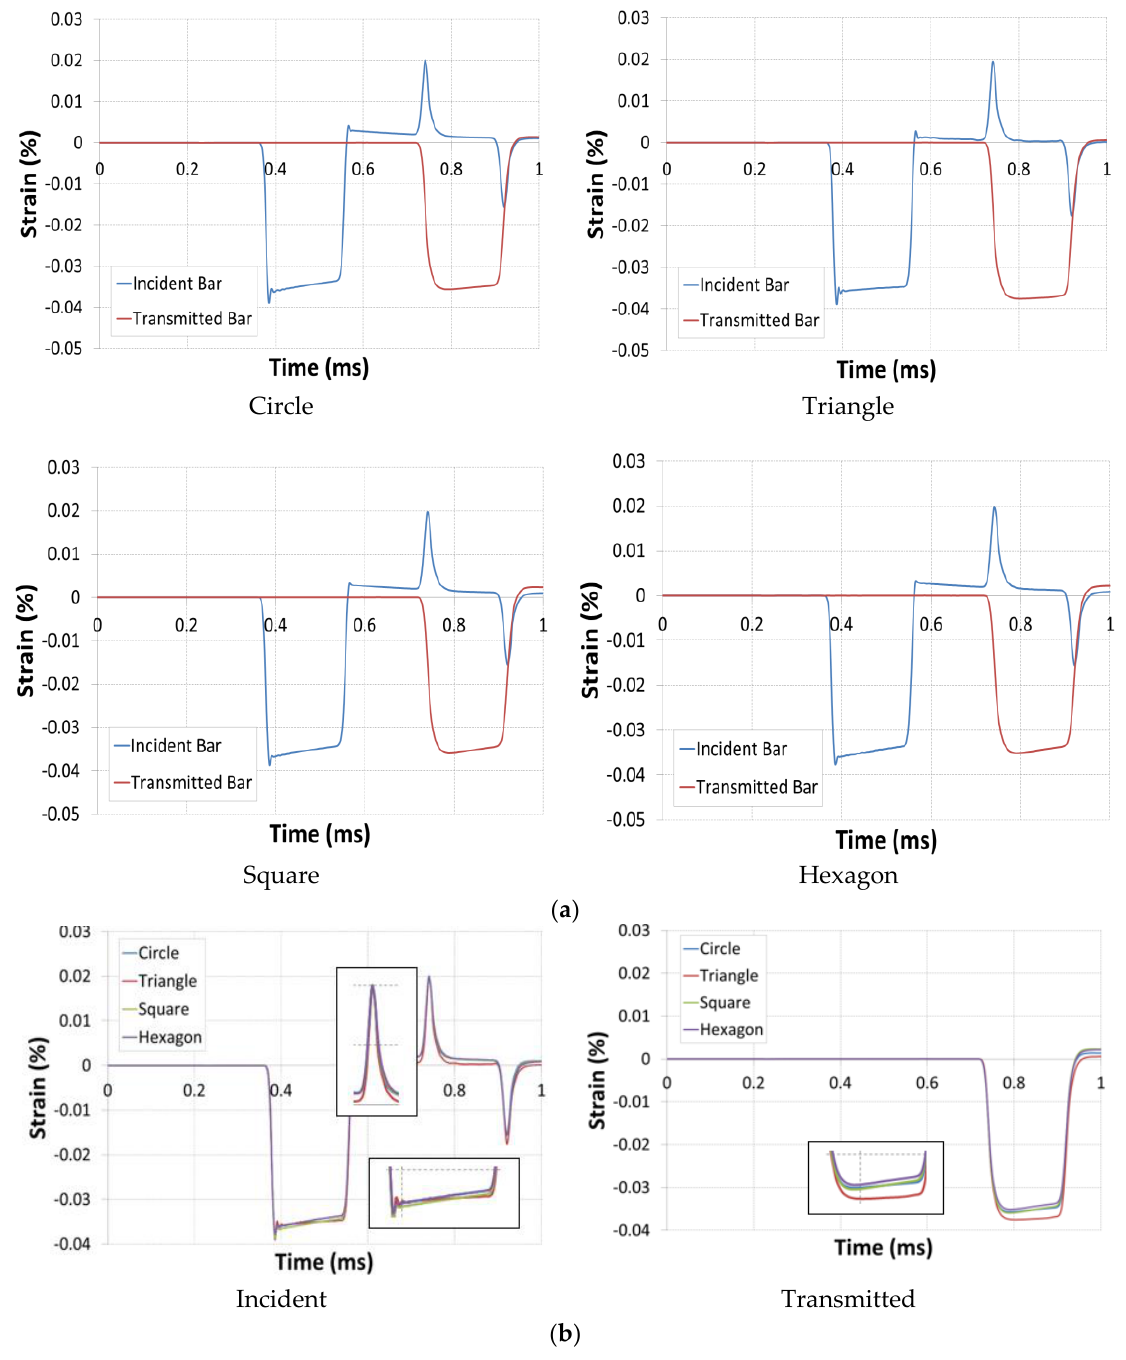
Figure 10. Dynamic response of the specimen under the velocity of V = 5 m/s . ( a ) Strain and ( b ) comparative signals.